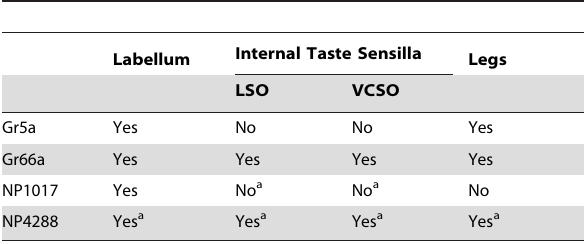
Table 1. Expression patterns of the GAL4 lines described in this study.